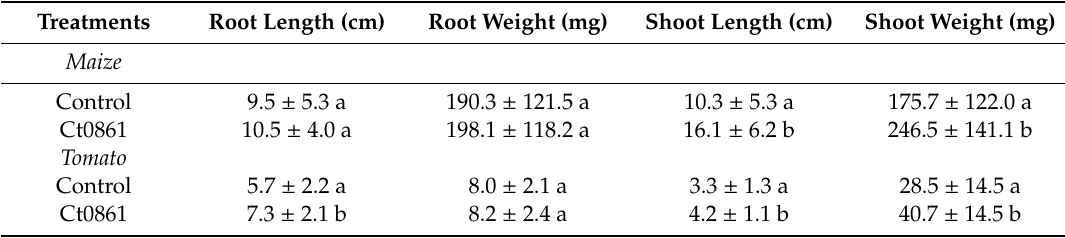
Table 3. E ff ect of Ct0861 on root and shoot growth of maize and tomato seedlings grown in vitro from inoculated seeds.